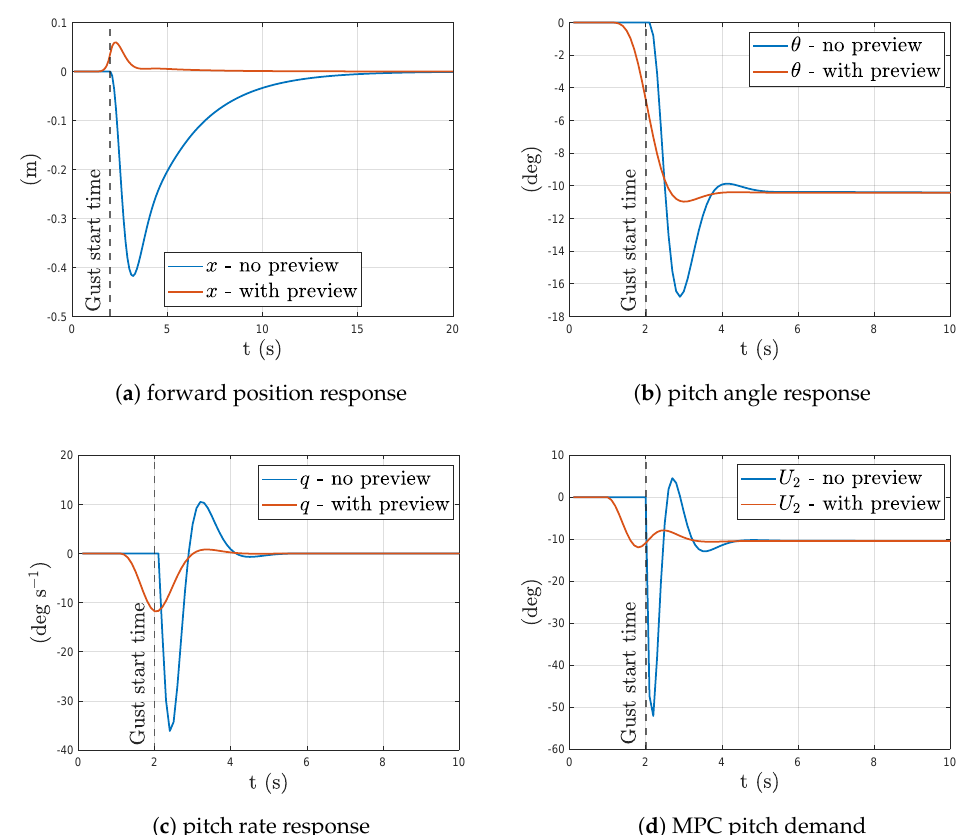
Figure 5. Linear aircraft response with and without wind preview control to a step input in forward wind of 10 ms − 1 at time t = 2